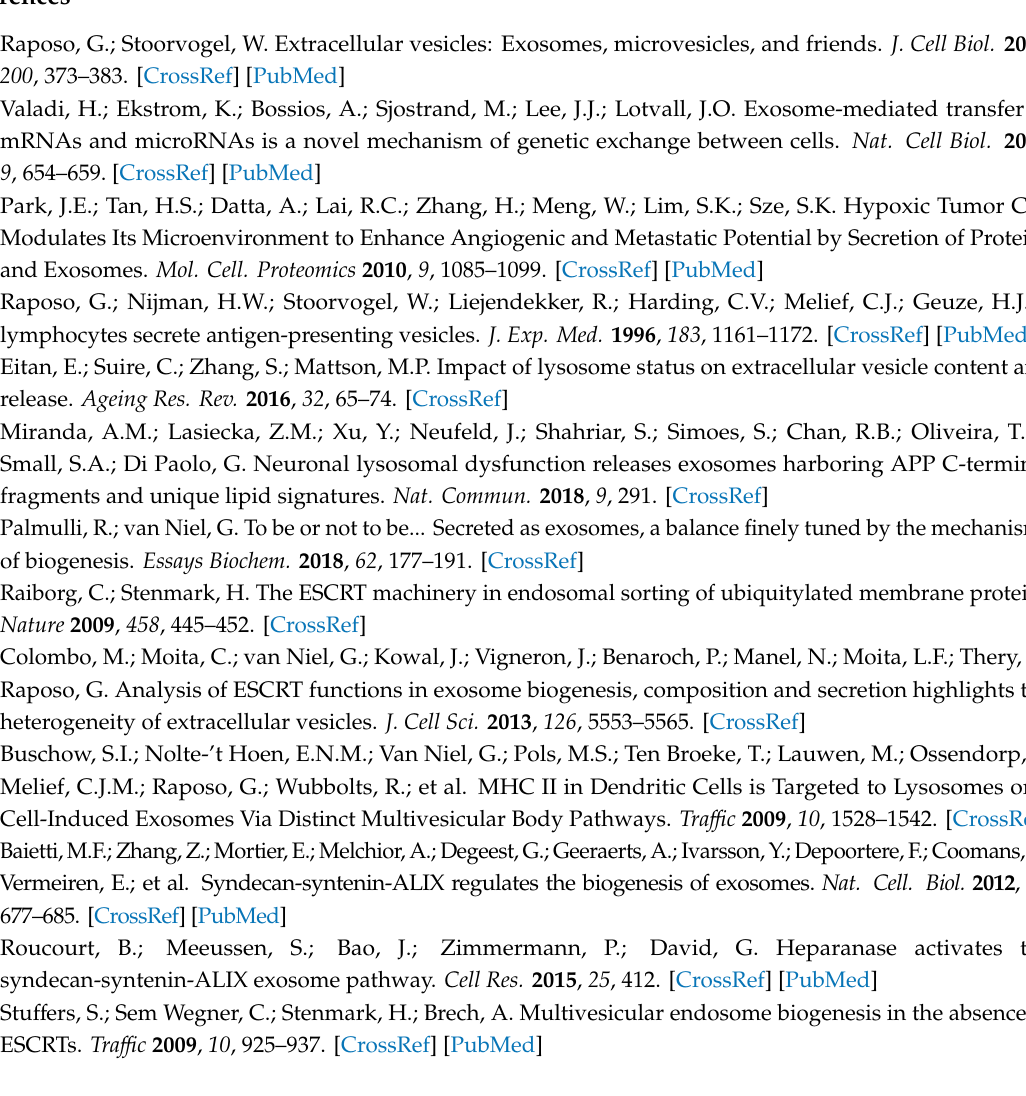
Figure S1: Number of proteins identified in Exocarta ( A ) and Vesiclepedia ( B ). Figure S2: pSILAC-based quantitative proteomics analysis of mHypoA 2 / 28 cell lysate, lysosome and EVs. Table S1: List of proteins that are associated with sphingolipid